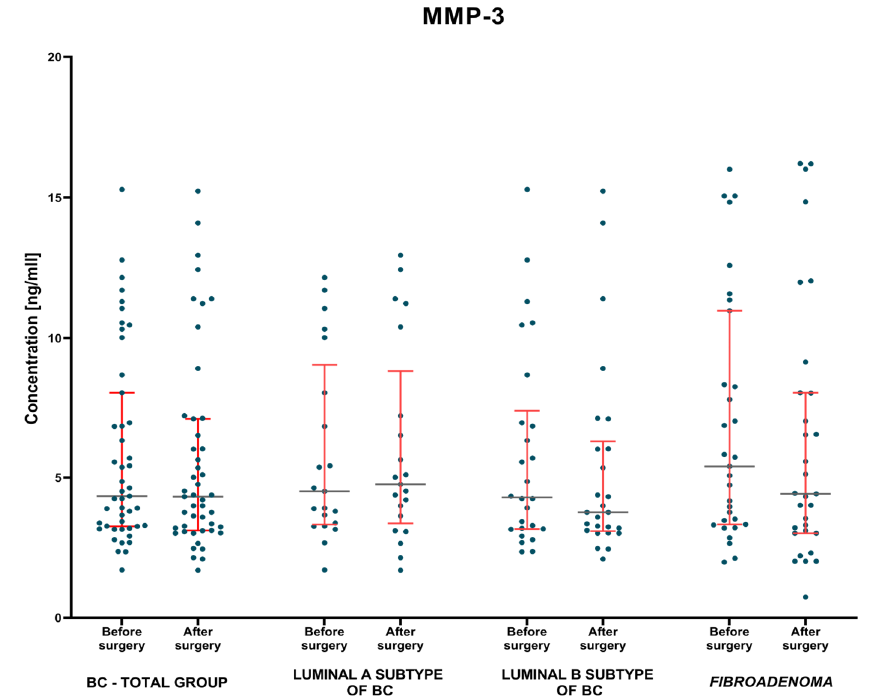
Figure 4. MMP-3 plasma concentrations (with marked median and interquartile range) in patients (total group and subgroups) with BC and fibroadenoma subjects before and after surgery.